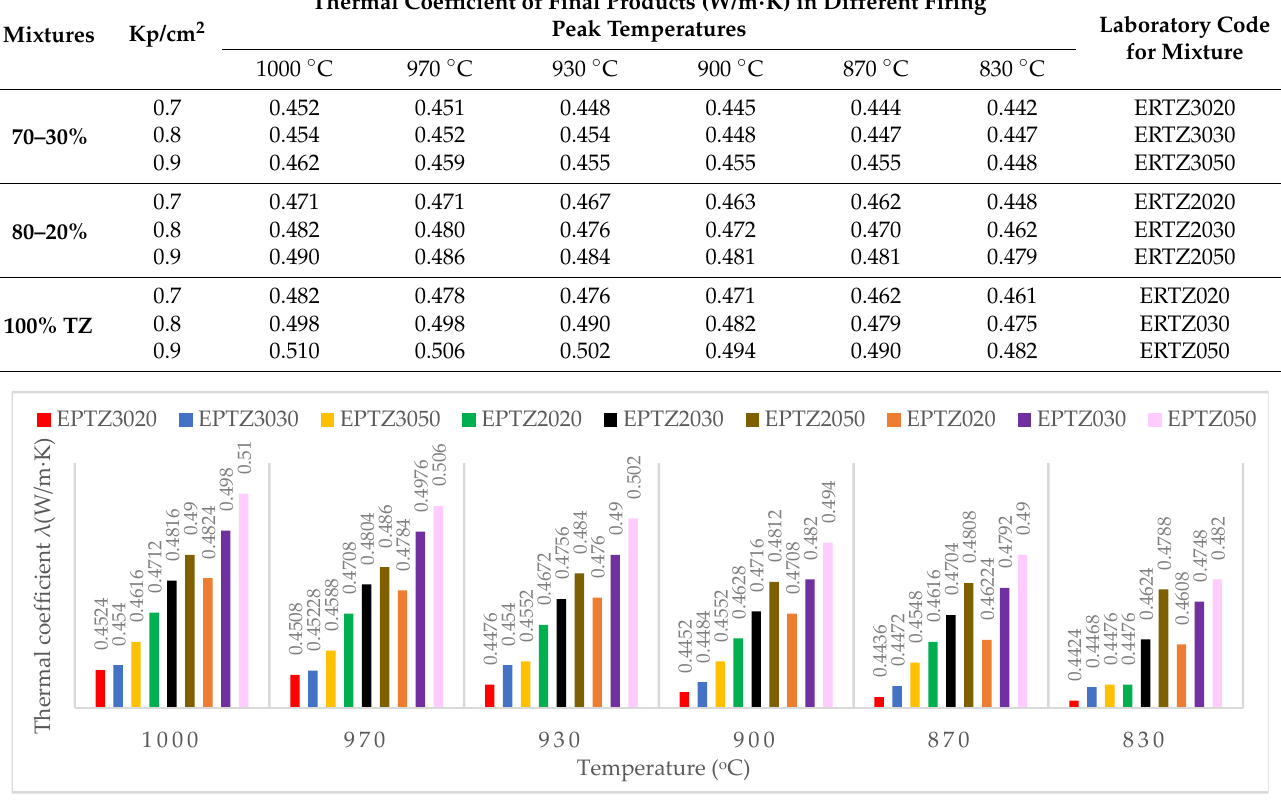
Table 9. Thermal conductivity coefficient of the tested samples.